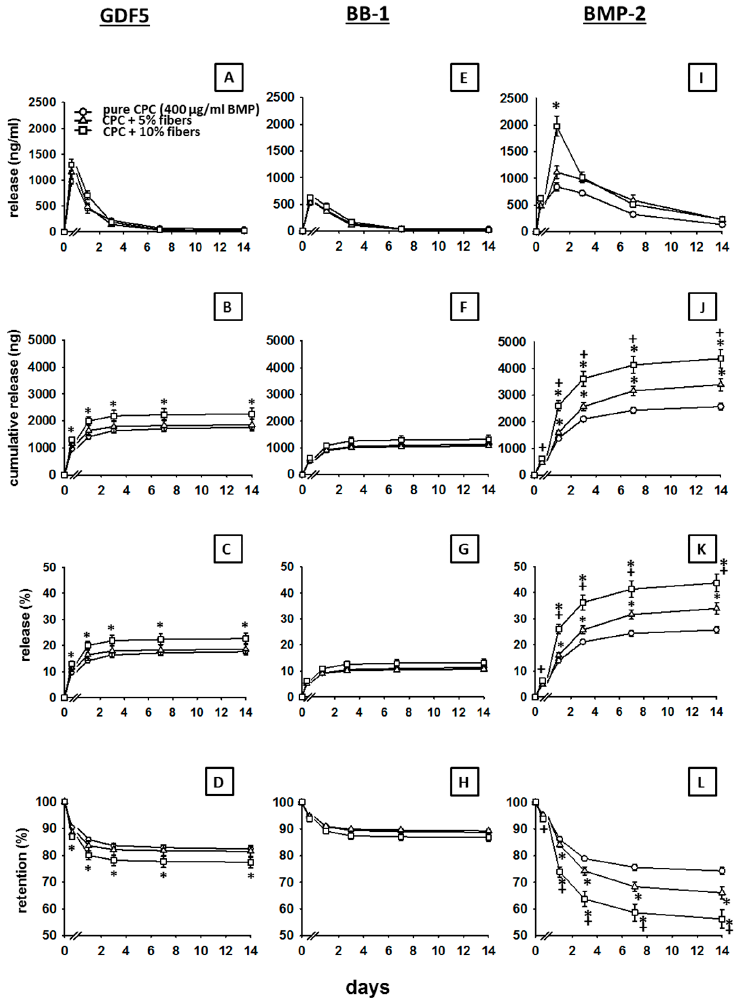
Figure 3. Release of GDF5, BB-1, and BMP-2 from PLGA fiber-reinforced CPC. Discs consisting of PLGA fiber-reinforced CPC ( r = 4.0 mm, h = 0.5 mm, V = 25.12 µL) were loaded with 400 µg/mL